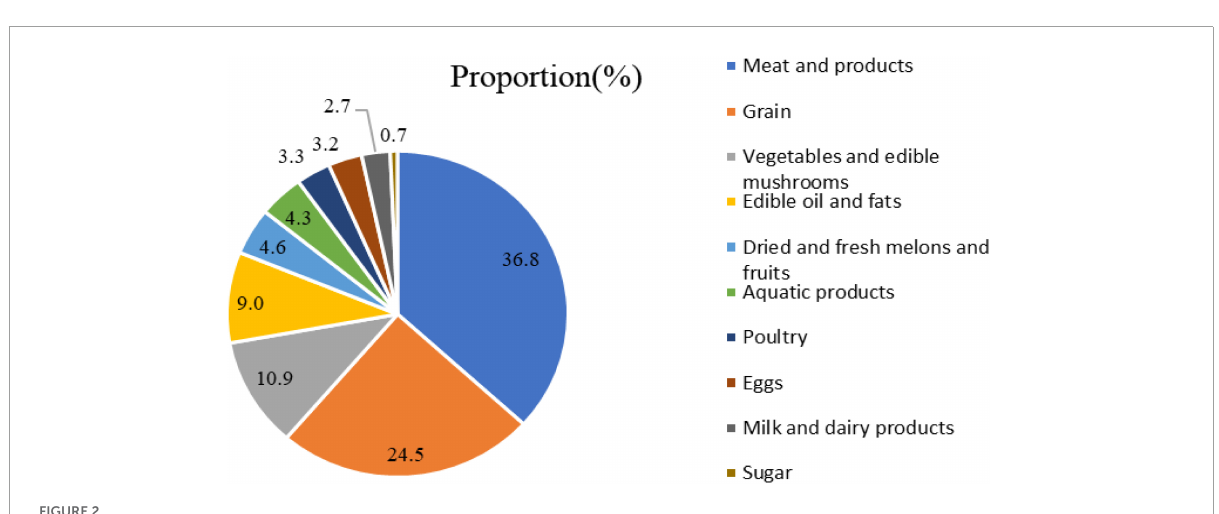
grain in the family with one older adult decreased by 67 and 54 yuan, respectively. In the case of a family with two or more older adults, the decrease in meat and meat products and grains was 178 and 109 yuan, respectively. Compared with the